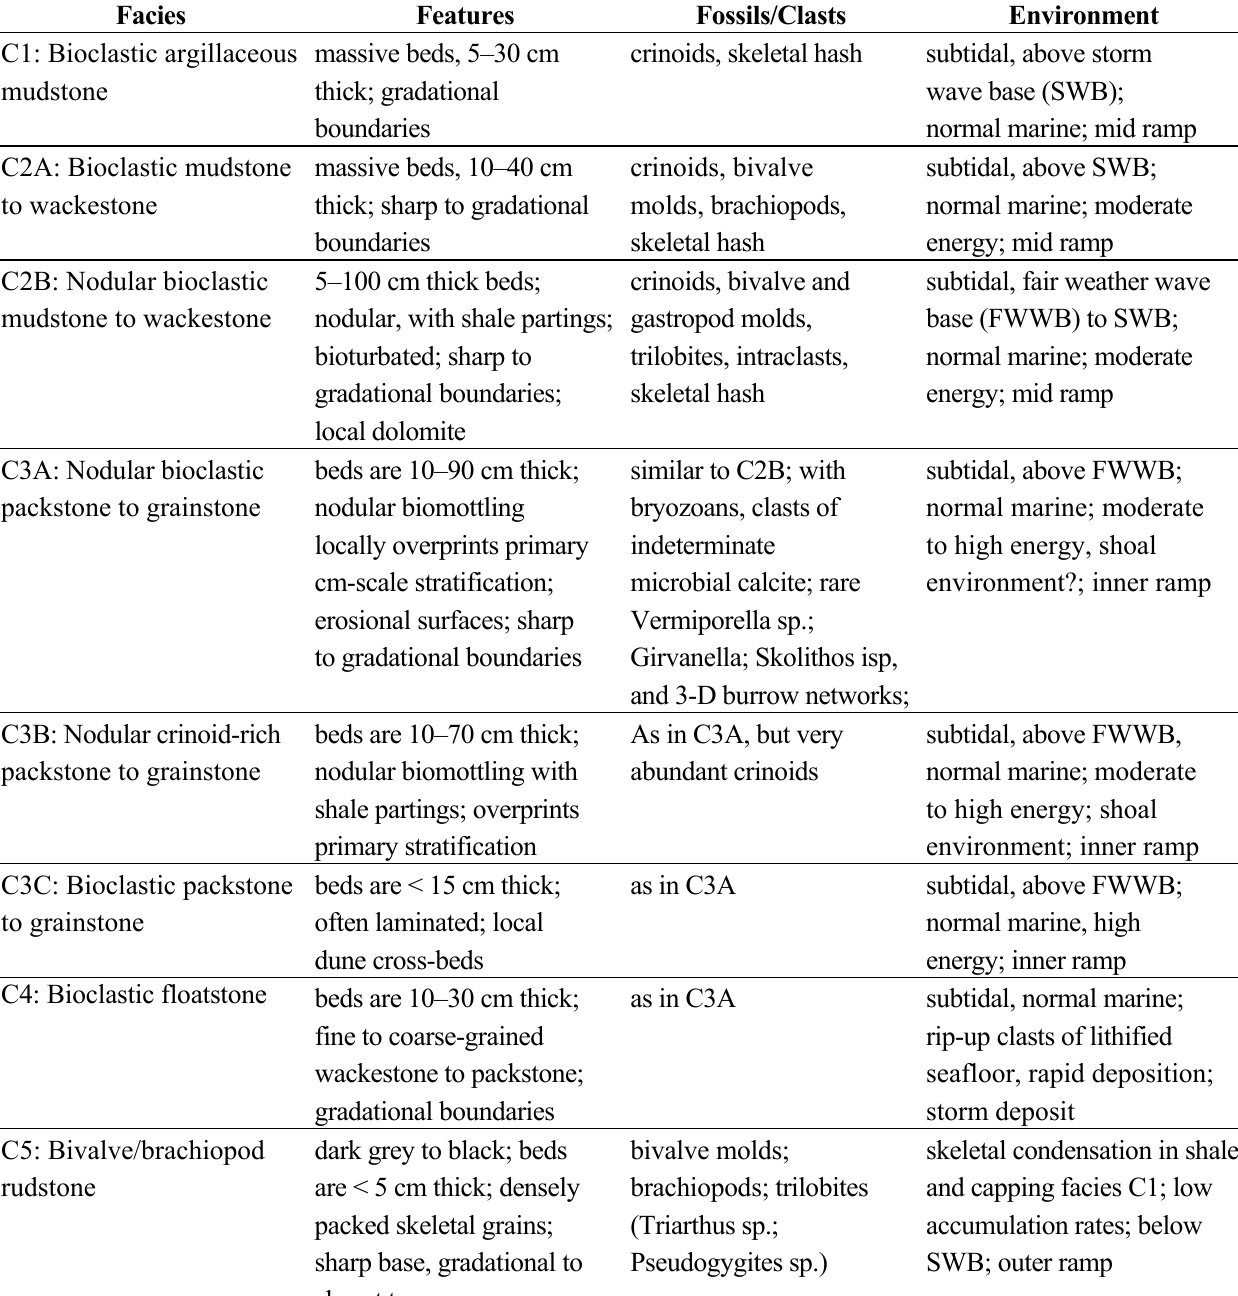
Table 2. Carbonate facies characteristics, Lindsay